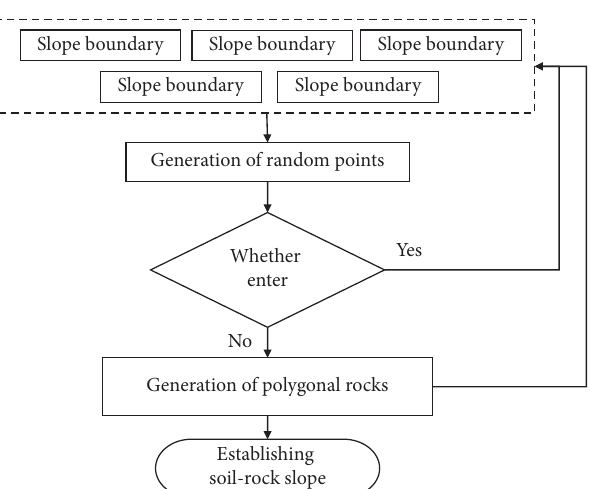
Figure 6: Established rocks considering interlock effect.